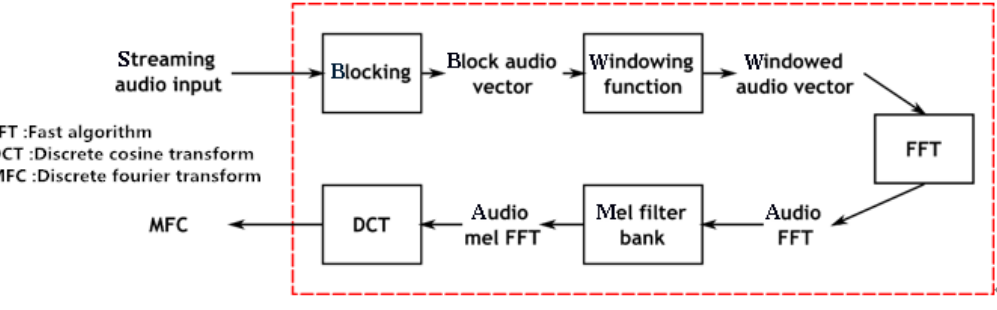
Figure 3. Mel Frequency Cepstral Coefficient (MFCC) calculation flow diagram. FFT: fast Fourier transform.